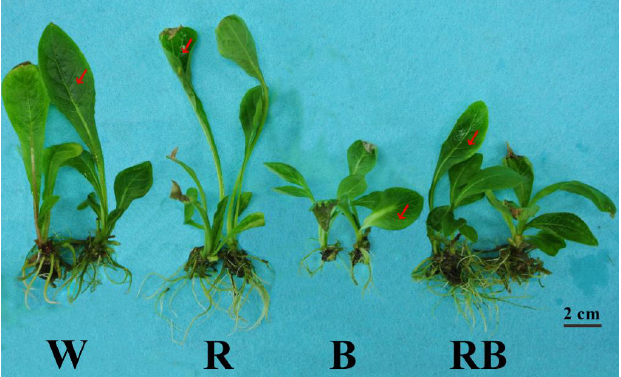
Figure 2. A representative picture of C. triste plantlets as affected by light quality after four weeks of culture: The light qualities used were W, white LED; R, red LED; B, blue LED; and RB, combined red and blue LEDs in a 1:1 ratio. The arrows show mature leaves of plantlets which were treated with different light qualities and used for measurement of parameters of chlorophyll a fluorescence. 3.2. Effect of Light Quality on Contents of Photosynthetic Pigments Chlorophyll a content in leaves of C. triste plantlets grown under RB was higher than that of plantlets grown under W, B, and R ( p < 0.05, Figure 3A). The W or RB were the most effective promoters of chlorophyll b accumulation ( p < 0.05, Figure 3B). Plantlets grown under RB had the highest total chlorophyll levels, followed by those grown under W, B, and R ( p < 0.05, Figure 3C). The chlorophyll a / b ratio did not show much difference between treatments ( p < 0.05, Figure 3D). In addition, W and RB were effective in increasing the content of total carotenoids in leaves of C. triste plantlets, whereas R and B were less effective in doing so ( p < 0.05, Figure 3E). Above all, RB led to increased total chlorophyll and carotenoid accumulation, which indicated that light quality may influence the photosynthetic performance through the photosynthetic pigments.